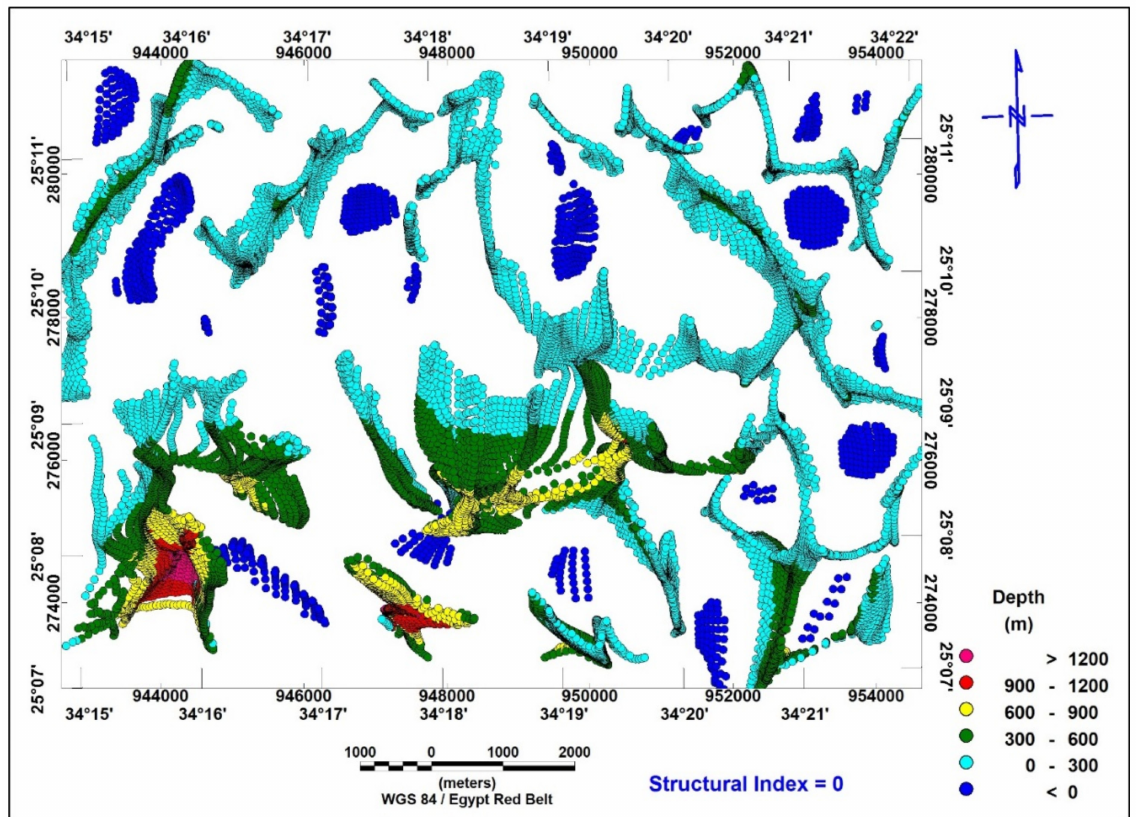
Figure 12. Depth of contacts using Euler deconvolution method (SI = 0) as deduced from RTP map of the study